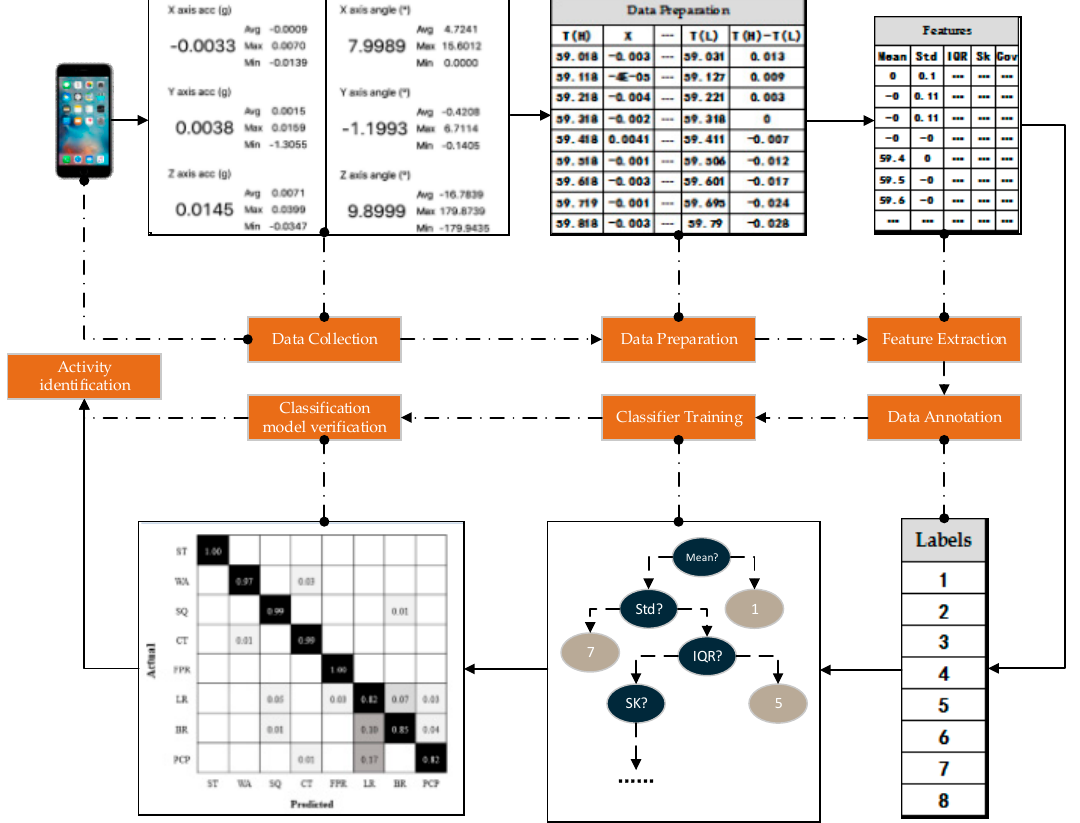
Figure 2. Framework of construction workers’ activity identification based on smartphones.